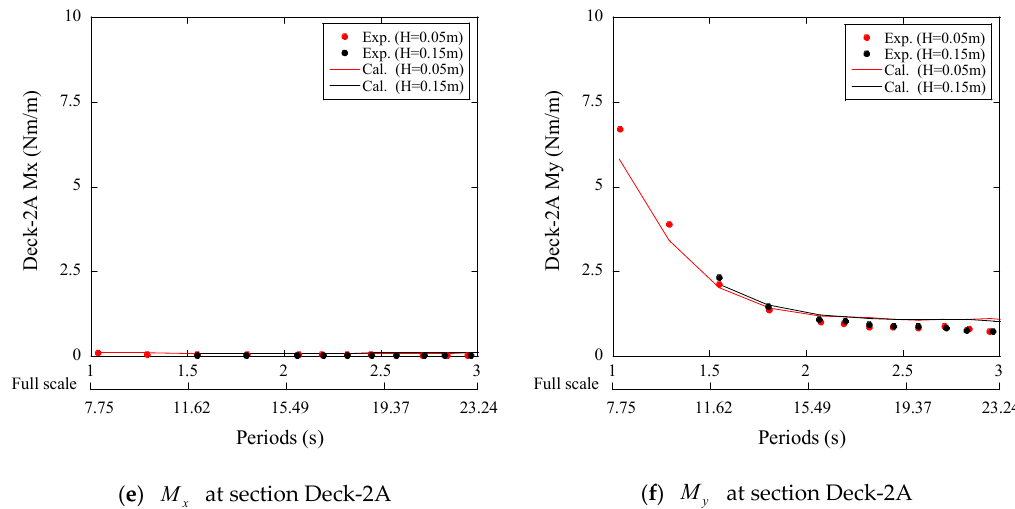
Figure 10. RAOs of moments about the local coordinate axis at specified sections. Figure 11 presents the PSD of the normalized M y at the sections Pn-2A and Deck-2A. The predicted bending moments show favorable agreement with the measured moments. The underestimation of M y at the section Pn-2A by the numerical model is observed in the low frequency range. This may be due to the second-order hydrodynamic loads, which is not considered in the numerical model.